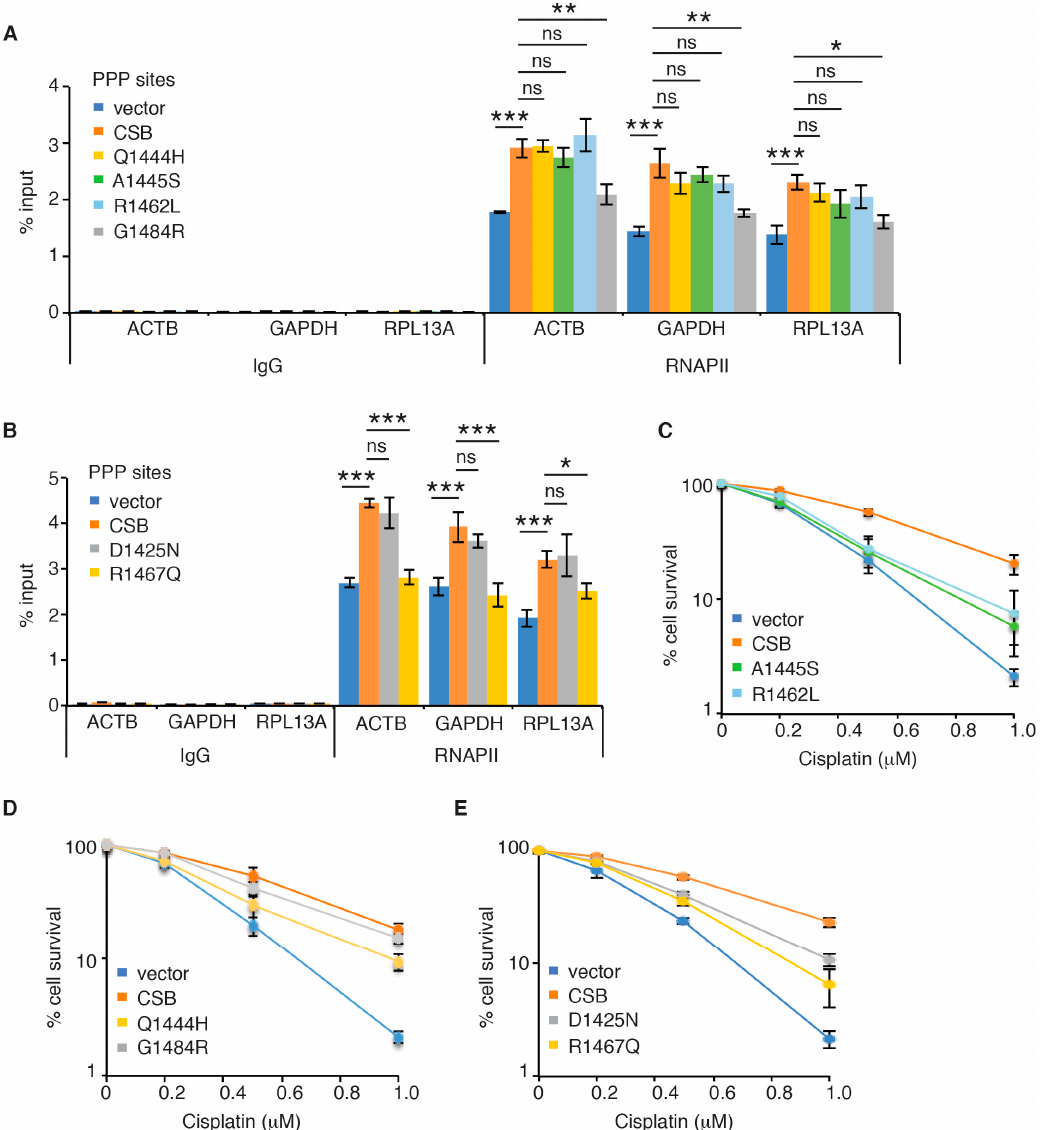
Figure 5. Cancer-associated R1467Q and G1484R mutations of CSB impair RNAPII pausing at PPP sites. ( A ) RNAPII ChIP analyses of ACTB , GAPDH and RPL13A genes in U2OS CSB-KO cells expressing the vector alone, Myc-CSB WT, Myc-CSB-Q1444H, Myc-CSB-R1462L, Myc-CSB-R1467Q or Myc-CSB-G1484R. Standard errors from three independent experiments are shown. p values were derived using the 2-way ANOVA test. * p < 0.05; ** p < 0.01; *** p < 0.001; ns: p > 0.05. ( B ) RNAPII ChIP analyses of ACTB , GAPDH and RPL13A genes in U2OS CSB-KO cells expressing the vector alone, Myc-CSB WT, Myc-CSB-D1425N or Myc-CSB-R1467Q. Standard errors from three independent experiments are shown. p values were derived using the 2-way ANOVA test. * p < 0.05; ** p < 0.01; *** p < 0.001; ns: p > 0.05. ( C ) Cisplatin clonogenic survival assays of U2OS CSB-KO cells expressing the vector alone, Myc-CSB WT, Myc-CSB-A1445S or Myc-CSB-R1462L. Standard deviations from three independent experiments are indicated. ( D ) Cisplatin clonogenic survival assays of U2OS CSB-KO cells expressing the vector alone, Myc-CSB WT, Myc-CSB-Q1444H or Myc-CSB-G1484R. Standard deviations from three independent experiments are indicated. ( E ) Cisplatin clonogenic survival assays of U2OS CSB-KO cells expressing the vector alone, Myc-CSB WT, Myc-CSB-D1425N or Myc-CSB-R1467Q. Standard deviations from three independent experiments are indicated.